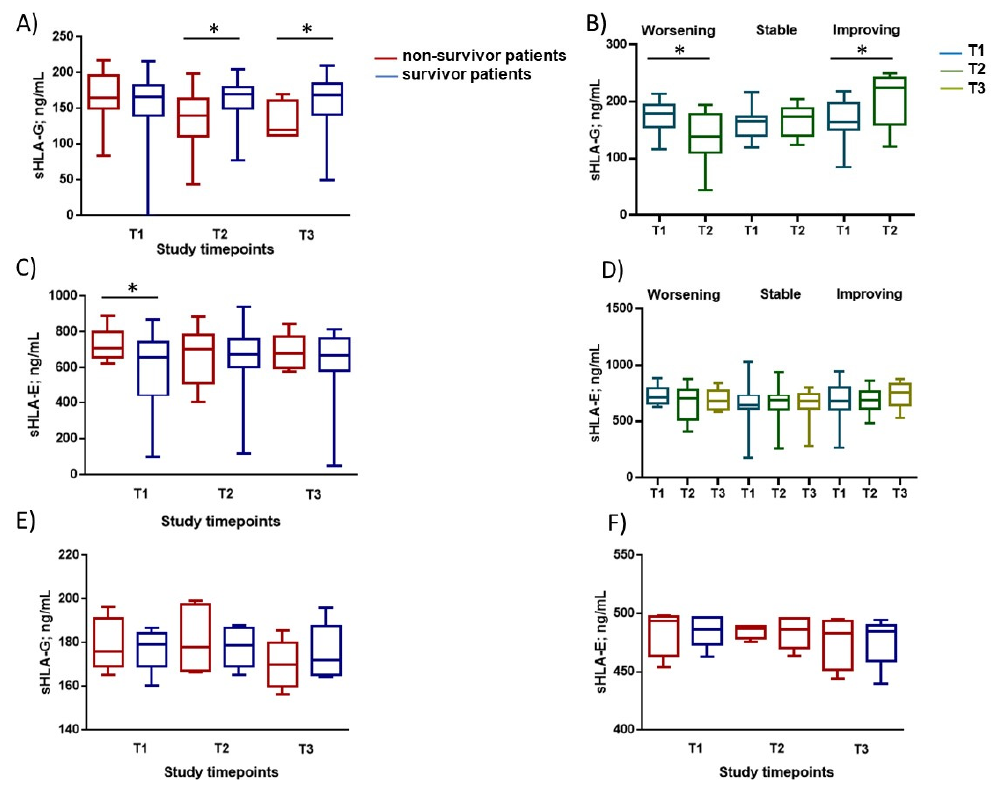
Figure 1. sHLA-G and sHLA-E concentration in blood of COVID-19 patients and controls. Blood sHLA-G and sHLA-E levels in COVID-19 patients and relationships with disease progression and clinical outcome: ( A , C ) Plasma sHLA-G and sHLA-E levels at baseline (T1) and at follow-up (T2 and T3; 7 ± 2 day interval between assessments) in non-survivor patients (red histograms) or survivor patients (blue histograms) during the study period. ( B , D ) Plasma sHLA-G and sHLA-E levels at baseline (T1) and after 7 ± 2 days (T2 and T3) on the basis of worsening, stability, or improving of the clinical manifestation of the disease (* p < 0.05, Student’s t -test). ( E , F ) Plasma sHLA-G and sHLA-E levels at baseline (T1) and at follow-up (T2 and T3; 7 ± 2 day interval between assessments) in non-survivor (red dots) or survivor (blue dots) control patients during the study